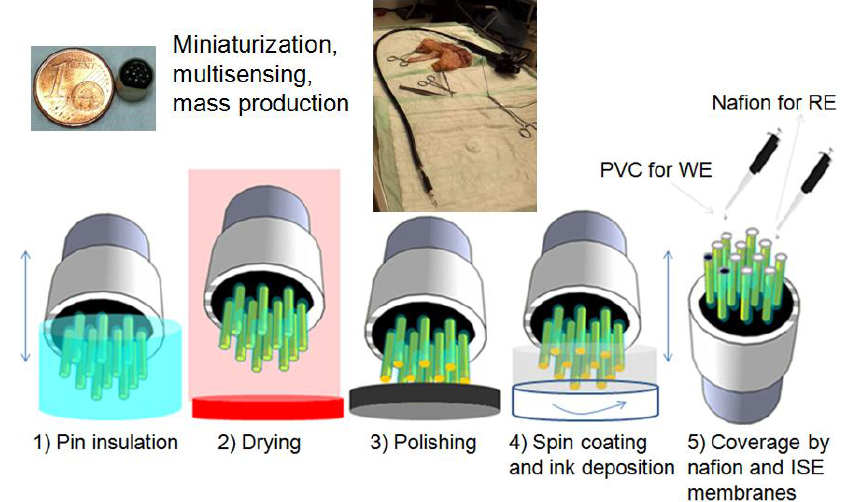
Figure 6. Fabrication steps of all-solid-state pH and nitrate sensors. The inlet picture shows the size of the array and the integration of the sensor array to the commercial